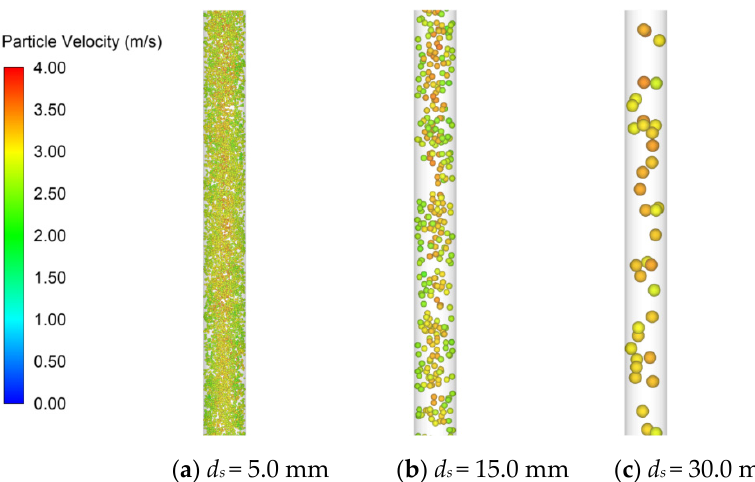
Figure 9. Instantaneous particle velocity distributions at different particle diameters ( V mix ,0 = 4.0 m/s, C v ,0 = 5%).